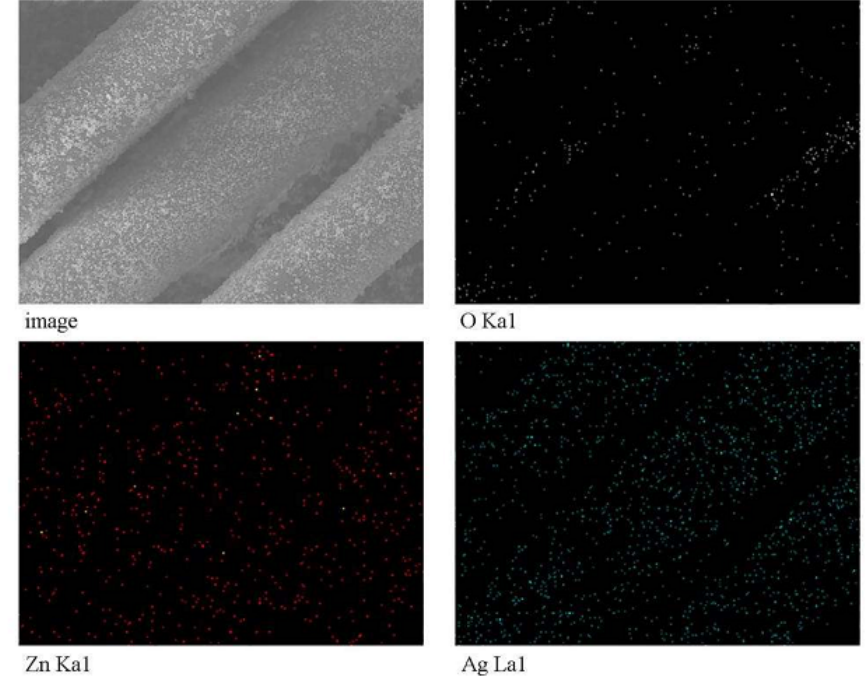
Figure 6. X-ray mapping images of ZnO/Ag composite coated polyester nonwoven